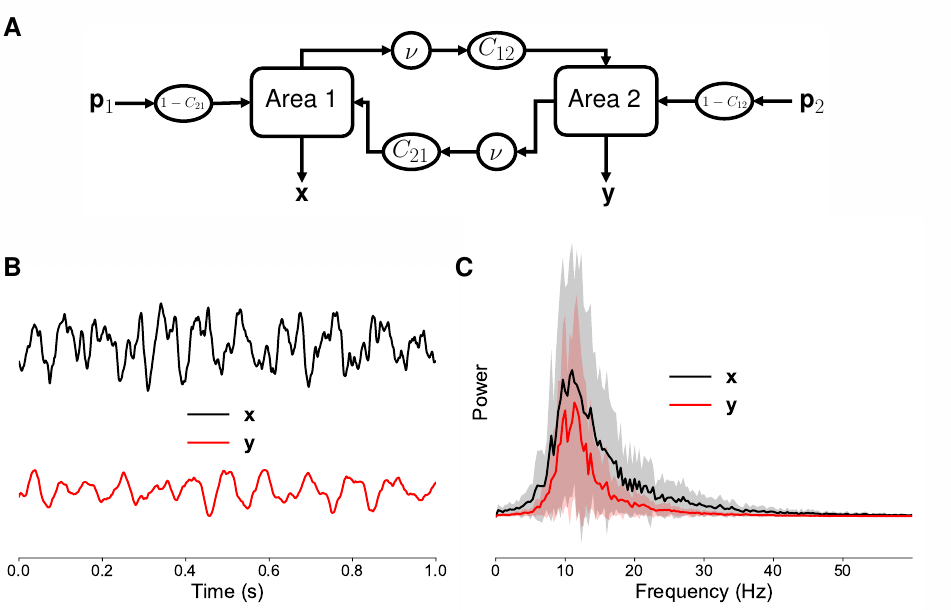
Figure 1. ( A ) Schematic representation of a neural mass model. ( B ) 1 s long unidirectionally coupled time series generated by the model. ( C ) Average power spectrums peaking in the α and lower β frequency